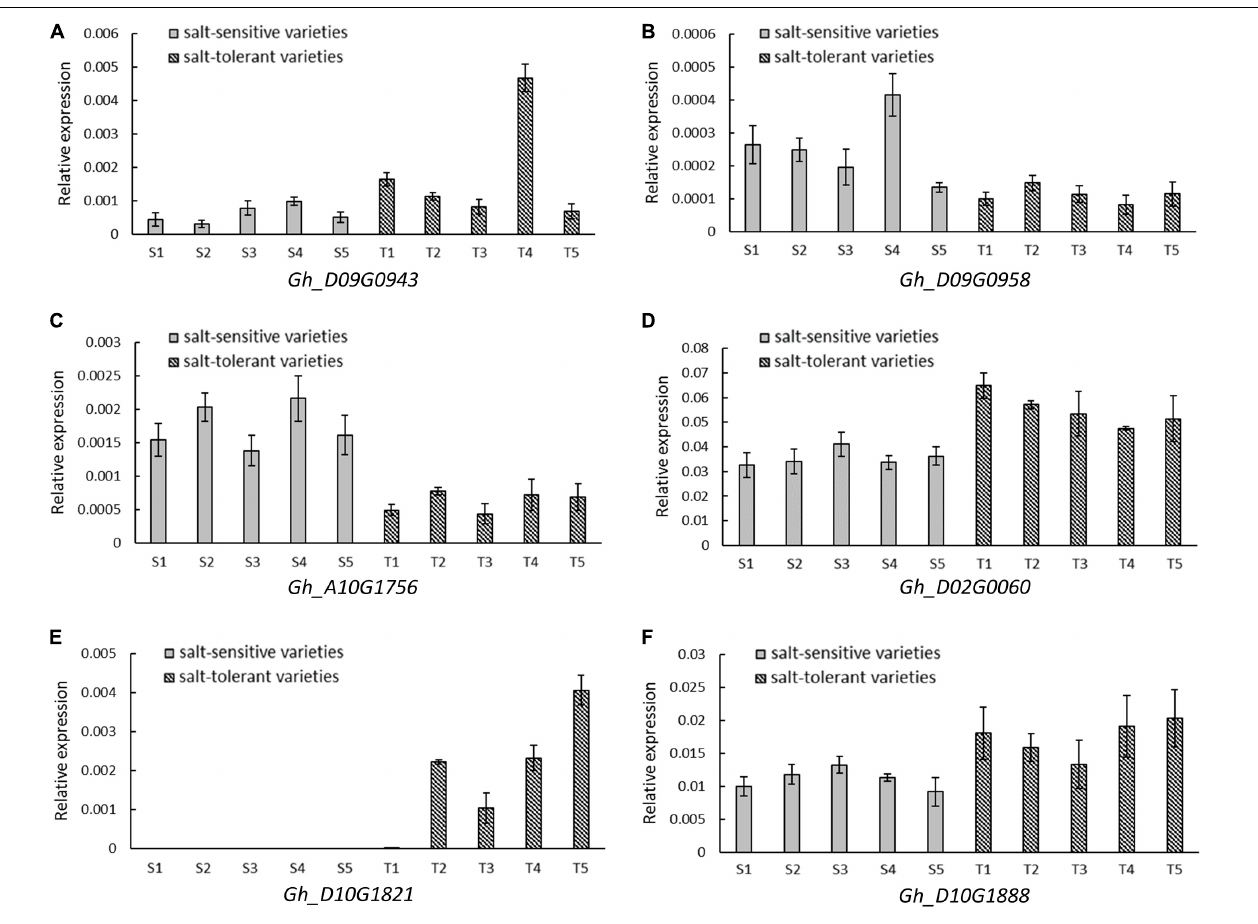
FIGURE 5 | Relative expression by quantitative RT-PCR of six candidate genes significantly associated with RSR and STL. (A) Gh_D09G0943 (NAC090). (B) Gh_D09G0958 (LEA). (C) Gh_A10G1756 (CPK1). (D) Gh_D02G0060 (CIPK2). (E) Gh_D10G1821 (UPL6). (F) Gh_D10G1888 (SINAT2). Five salt-sensitive varieties, S1: Pengze70, S2: Shannmian10, S3: Lumianyan35, S4: Jiwu2833, S5: Xinluzao38; five salt-tolerant varieties, T1: Zhongwu1038, T2: CCRI20, T3: Zhongkang5, T4: Litai8, T5: